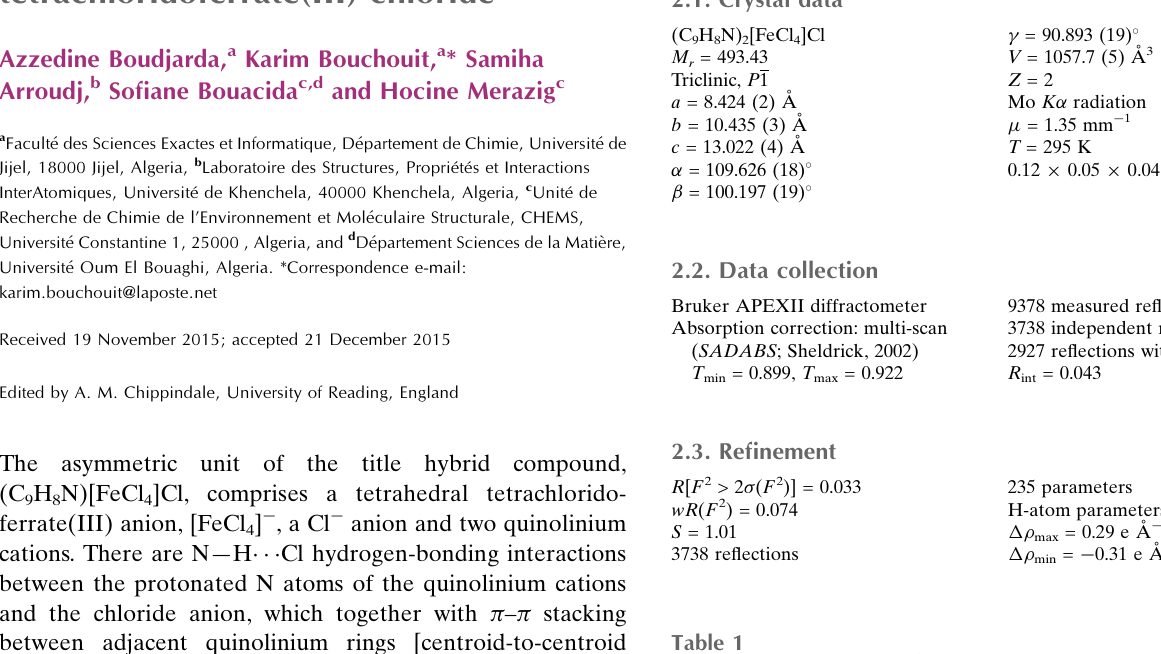
Hydrogen-bond geometry (A˚ , (cid:4)